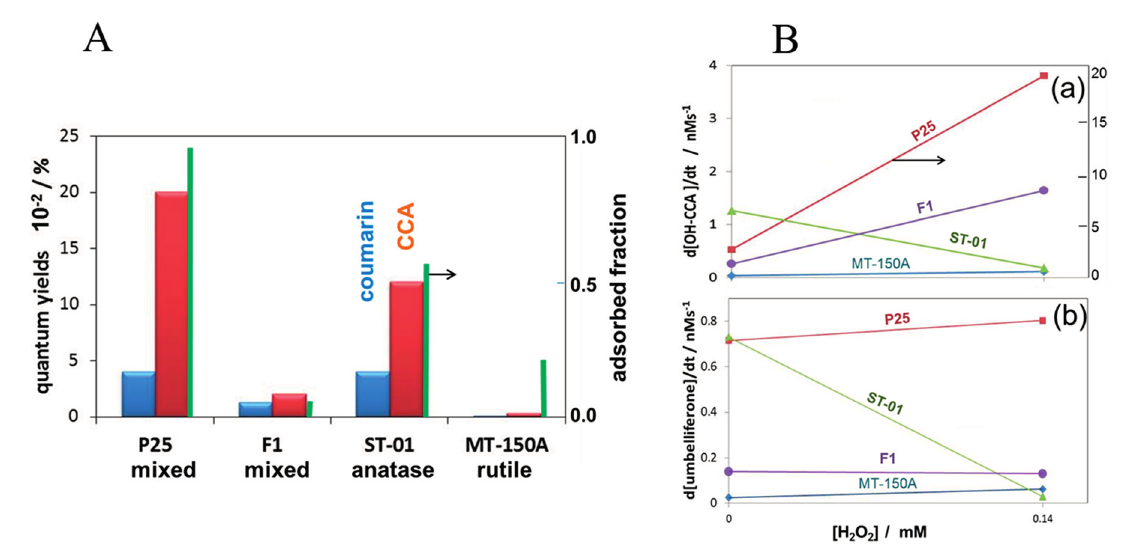
Figure 11. ( A ) Quantum yields of •OH using the different probe molecules, coumarin (blue) and CCA (brown), and the fraction of adsorbed CCA (green) for four kinds of TiO 2 powders; ( B ) Effect of the addition of 0.14 mM H 2 O 2 on the formation rates of ( a ) OH-CCA and ( b ) umbelliferone. Reprinted with permission from [36]. © 2014 American Chemical